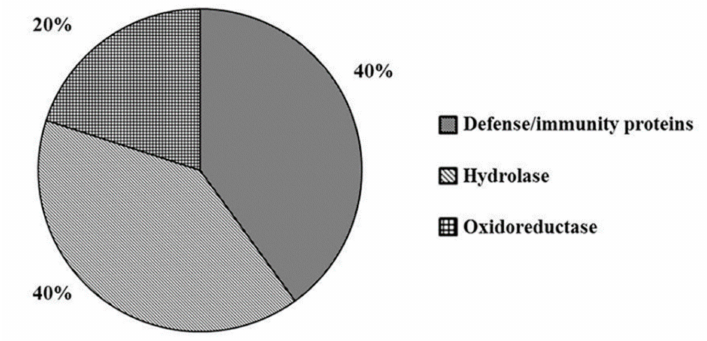
Figure 4. Functional classification of the 26 DEPs after MeJA + W, using PANTHER gene ontology (GO) analysis. The proteins were classified into protein